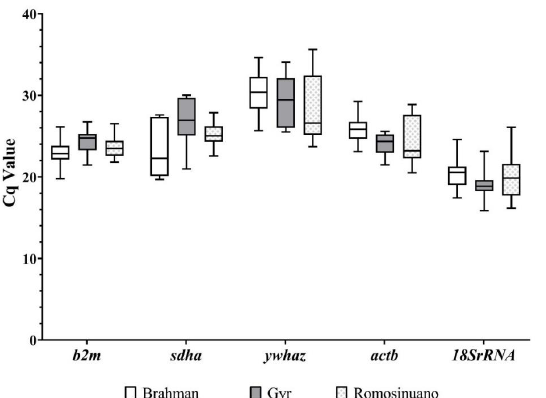
Figure 2. Cq values for five reference genes of the blood samples among different bovine breeds. The Cq values of the b2m , sdha , ywhaz , actb , and 18S rRNA reference genes from Brahman (white boxes), Gyr (dark gray boxes), and Romosinuano (dotted light gray boxes). The box indicates the 25th and 75th percentiles, the lines represent the median, squares represent the means, and whiskers represent the maximum and minimum values.